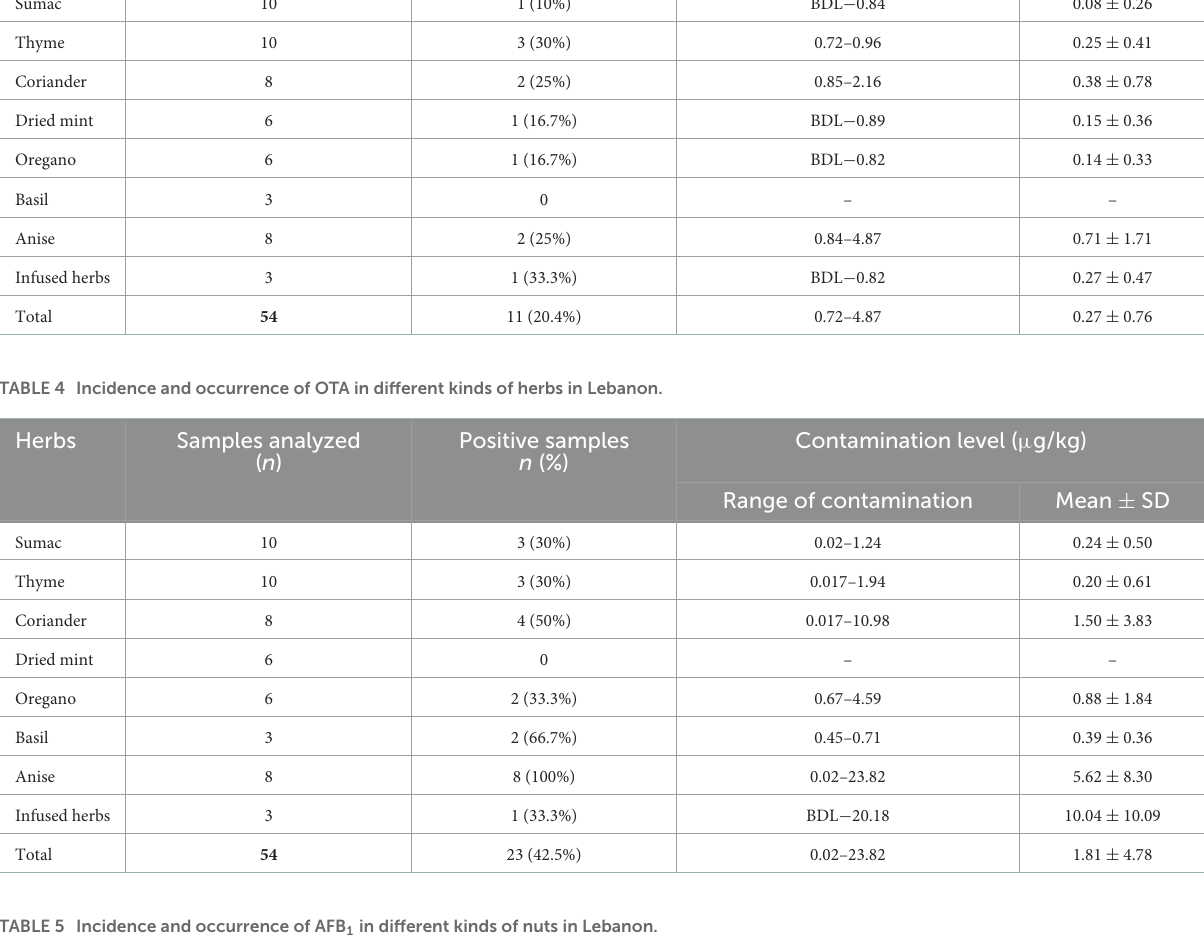
TABLE 5 Incidence and occurrence of AFB 1 in different kinds of nuts in